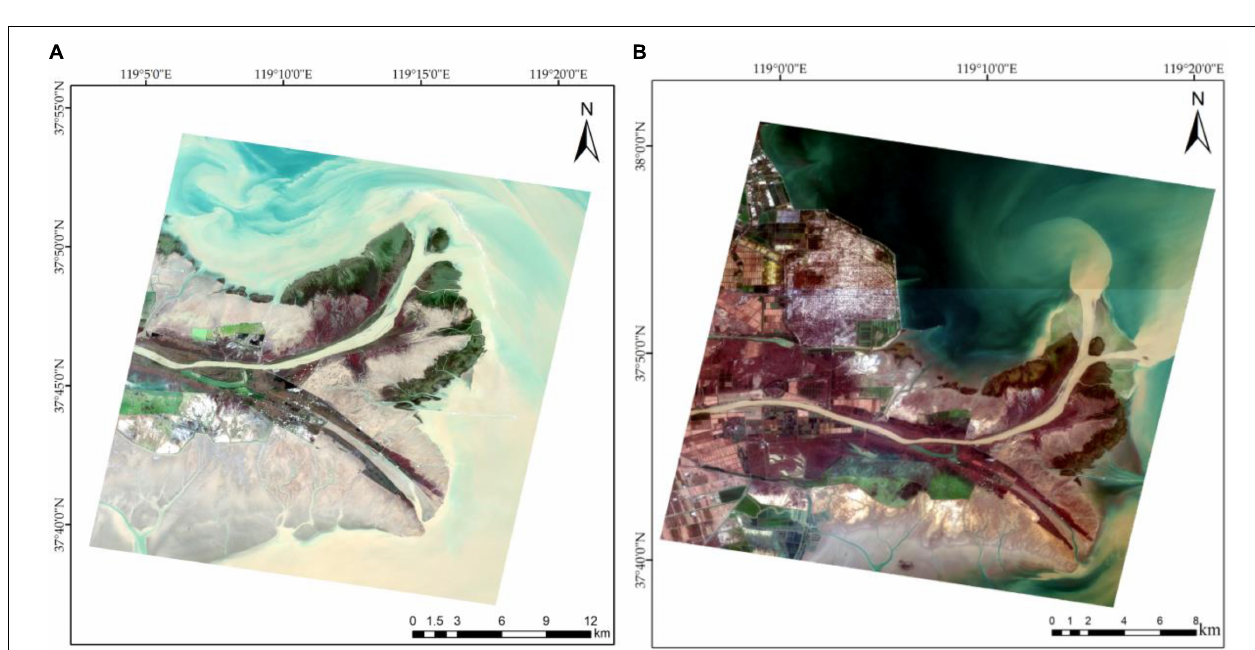
FIGURE 2 | Result of the color synthesis of the GF-3 polarization channels. The darker areas in the image are mainly water or tidal flat, and the brighter coastal areas are vegetation, mainly S. alterniflora and P. australis . (A) Image obtained on October 12, 2017; (B) Image obtained on November 05, 2018.